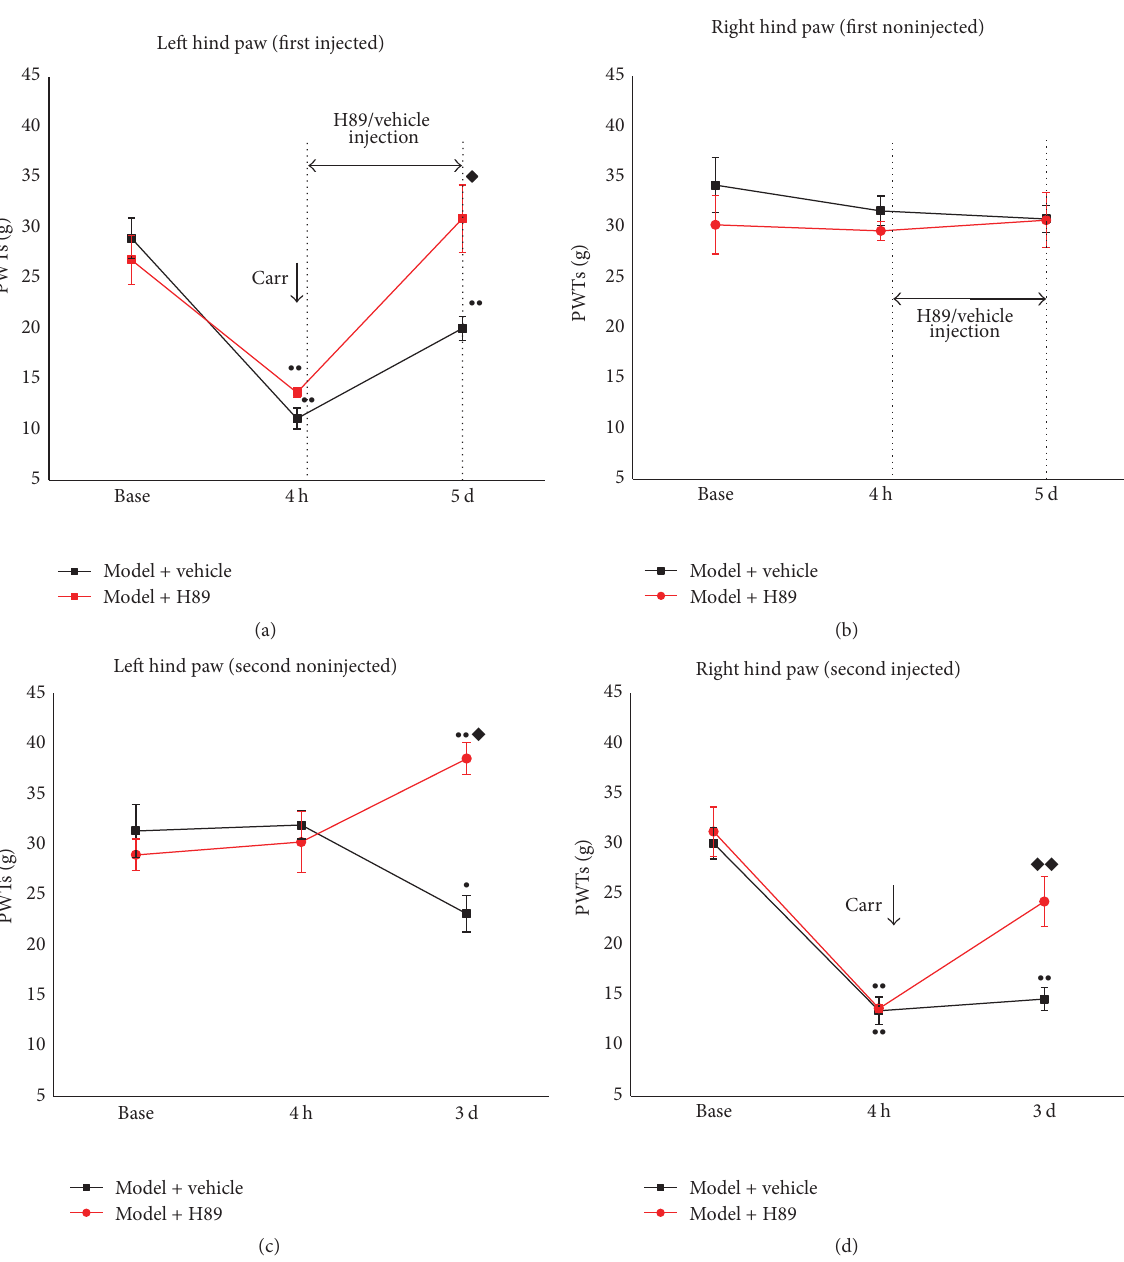
Figure 4: The effects of the PKA inhibitor of pain memory model. The rats were divided into the model + vehicle and the model + H89 groups and the mechanical allodynia was examined ( 𝑛 = 7 ). (a) In the left hind paw (first injected), the PKA inhibitor intervention significantly increased the PWTs from acute inflammatory pain. (b) In the right hind paw (first noninjected), the PWTs of the two groups were not signifi- cantlydifferent.(c)Inthelefthindpaw(secondnoninjected),PKAinhibitorinterventionsignificantlyincreasedthePWTsfrompainmemory. (b) In the right hind paw (second injected), PKA inhibitor intervention significantly increased the PWTs compared with the model + vehicle group. Error bars indicated SEM. X 𝑝 < 0.05 and XX 𝑝 < 0.01 , versus the model + vehicle group; e 𝑝 < 0.05 and ee 𝑝 < 0.01 , versus